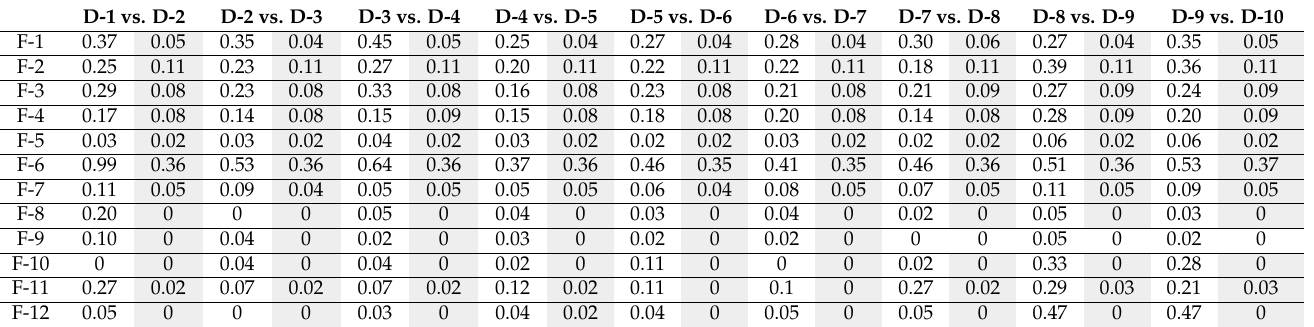
Table 1. Comparative study of ten consequence days between spam and non-spam using